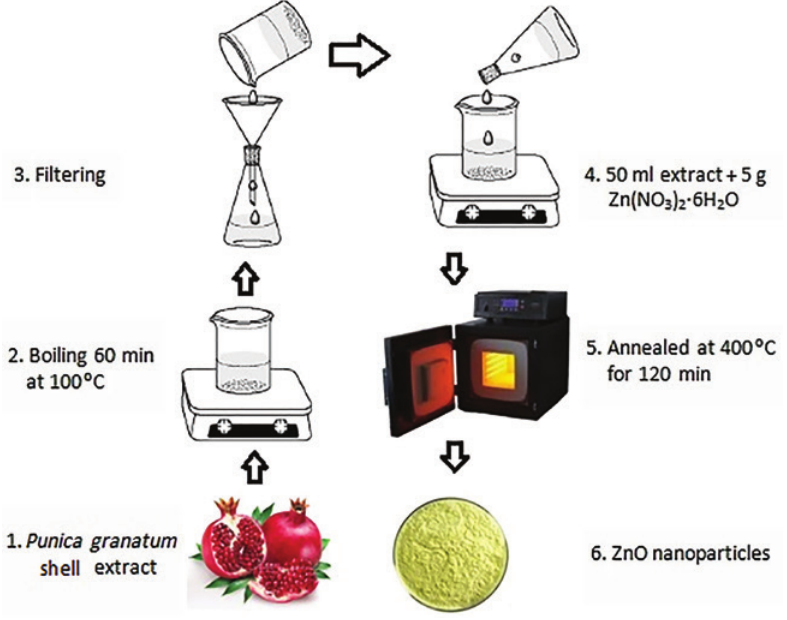
Figure 1: Sample preparation process for zinc oxide nanoparticles